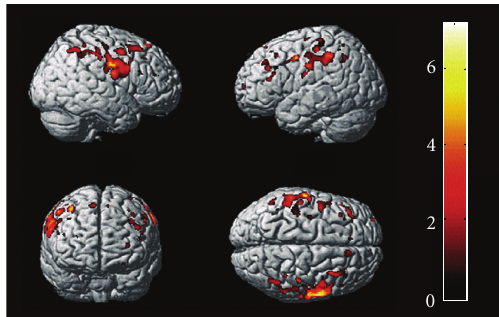
Figure 1: Regional grey matter atrophy in ALS patients compared with controls: group comparison of ALS patients versus healthy controls showed regional grey matter atrophy in the precentral and postcentral gyrus bilaterally, which extended from the primary motor cortex to premotor, parietal and frontal regions bilaterally. The colour bar indicates the statistical strength of the regional atro- phy (yellow-white is most significant). Adapted from Grosskreutz and coworkers